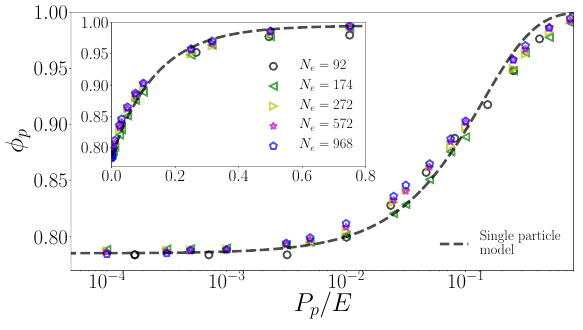
Figure 5. The packing fraction as a function of the scaled pres- sure applied on the particle for di ff erent mesh resolutions, N e